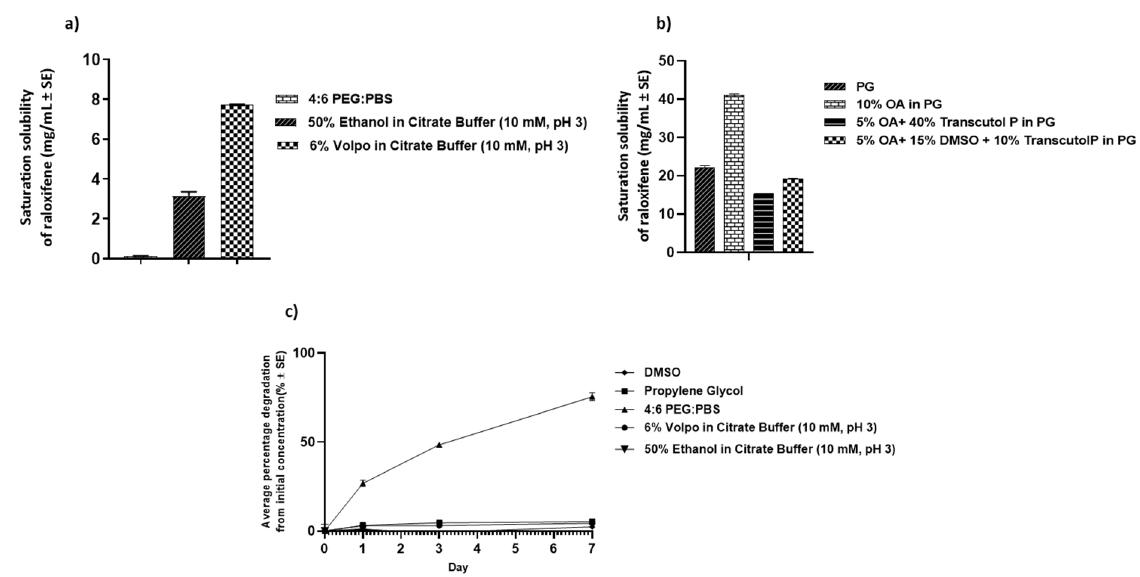
Figure 1. Solubility and stability studies: ( a ) solubility of RLX in receptor solutions; ( b ) solubility of RLX in combination with chemical enhancers; ( c ) stability profile of RLX in various vehicles at 37 °C; n = 4; PEG: polyethylene glycol 400, PBS: phosphate-buffered saline, PG: propylene glycol, OA: oleic acid, DMSO: dimethyl sulfoxide.